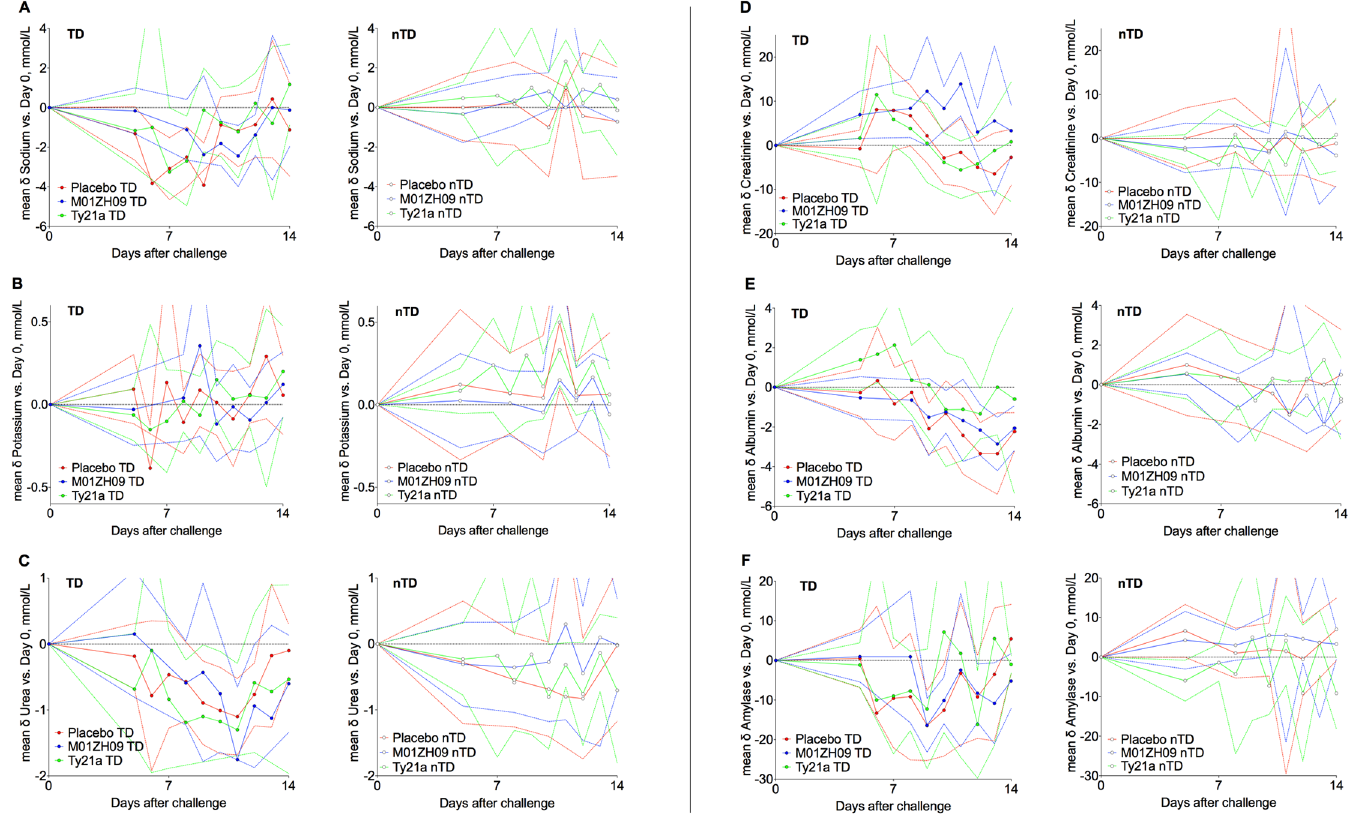
Fig 6. Group mean changes (95% confidence intervals) in haematological blood parameters compared to pre-challenge measurements according to vaccine allocation and challenge outcome. (A) Haemoglobin, (B) platelets, (C) total white cell count, (D) neutrophils, (E) lymphocytes, and (F) eosinophils. TD, typhoid diagnosis; nTD, non-typhoid